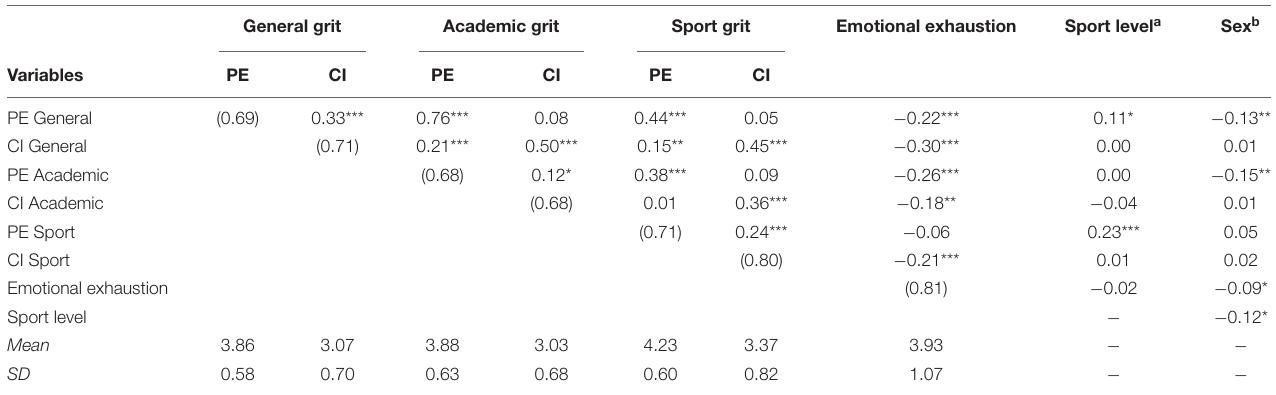
TABLE 3 | Means, standard deviations, correlations, and internal consistency values ( α ) for variables of interest. General grit